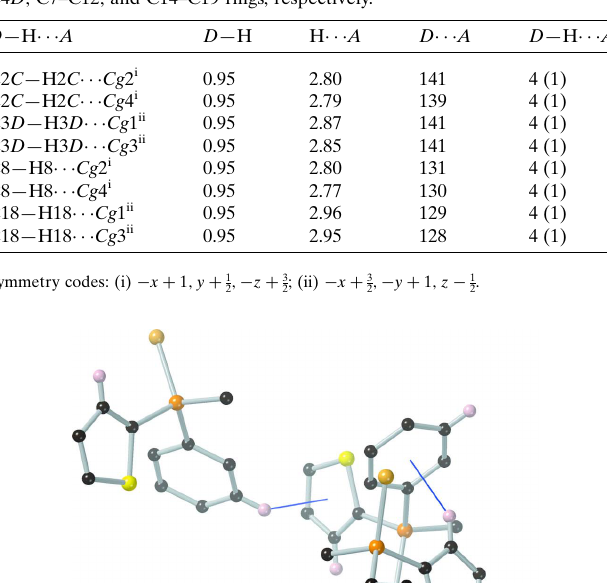
Table 1 C—H (cid:2)(cid:2)(cid:2) (cid:2) interactions (A˚ , (cid:3) ). Cg 1, Cg 2, Cg 3, and Cg 4 are the centroids of the S1 C /C1 C –C4 C , S1 D /C1 D – C4 D , C7–C12, and C14–C19 rings,